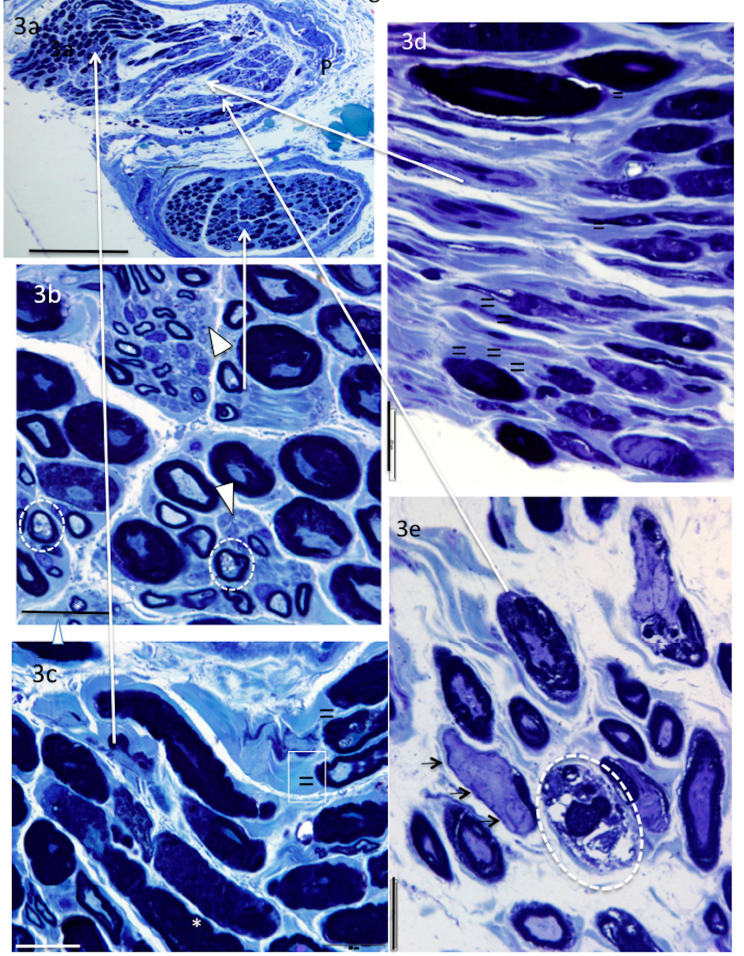
Figure 3. Methylene- ( a – c ) and toluidine ( d – e ) blue-stained sections from AIN. In addition to thickened, split and folded myelin, AIN and PIN nerves showed both transverse ( b , e ) and longitudinal orientation of axons ( c , d ). Abnormally pale-stained myelin (possibly uncompacted) can be seen surrounding the typically dark staining myelin ( c , d ). Note the large demyelinated axons, clearly lacking the myelin component ( e ) and degenerating vacuolated axons ( b ) or myelin without an axon ( e ). Small myelinated (*) and unmyelinated axons (arrowheads) were also observed. Demyelinated axons (small arrows), abnormally pale stained myelin abutting normal myelin (=), degenerating axons (enclosed in white circles). Perineurium (P), long arrows show region of high oower micrographs bar = 200 μ m ( a ), 20 μ m ( b – e ).